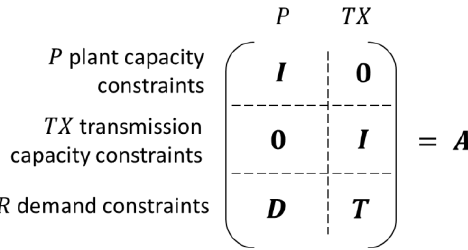
Figure 3. Layout of constraint matrix 𝑨 . Capital letters on the outside describe the matrix dimensions . The final 𝑅 = 10 rows in Figure 3 correspond to the demand constraints, one for each market region. Within these final rows, the 𝑅 × 𝑃 submatrix 𝑫 is built by assigning 1 to each element whose column 𝑝 corresponds to a plant in the region corresponding to row 𝑟 ( ∀𝑝 ∈ 𝑟 ). Furthermore, the 𝑅 × 𝑇𝑋 submatrix 𝑻 is built by assigning 1 to each element whose column 𝑡𝑥 represents a transmission flow into the region corresponding with row 𝑟 ( ∀𝑡𝑥 ∈ 𝑟 ). In this way, the elements are assigned according to Equation (8). This ensures that for each hour, the elements of 𝒙 are chosen such that the sum of all plants and transmission imports meets demand for each market region.